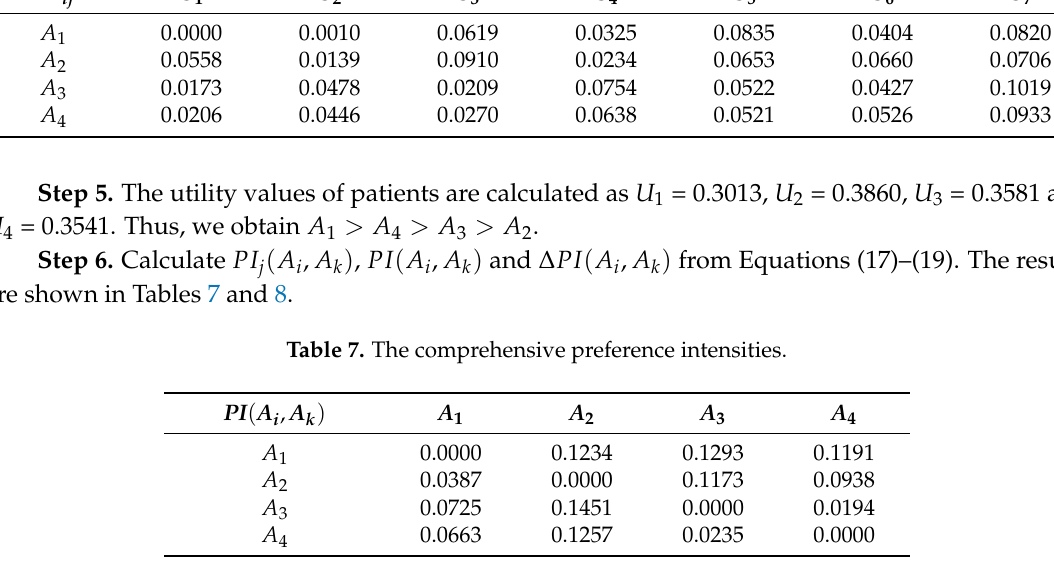
Table 8. The net preference